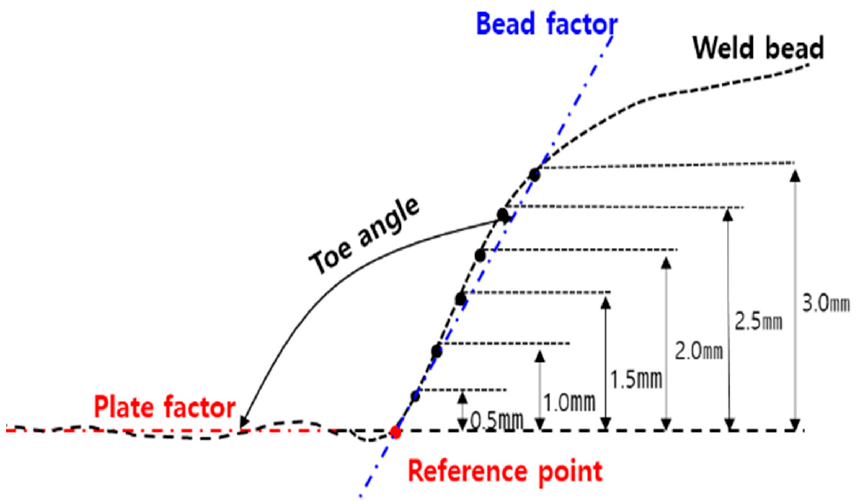
Figure 15. Schematic diagram of the toe angle measurement (toe ~ 3 mm).